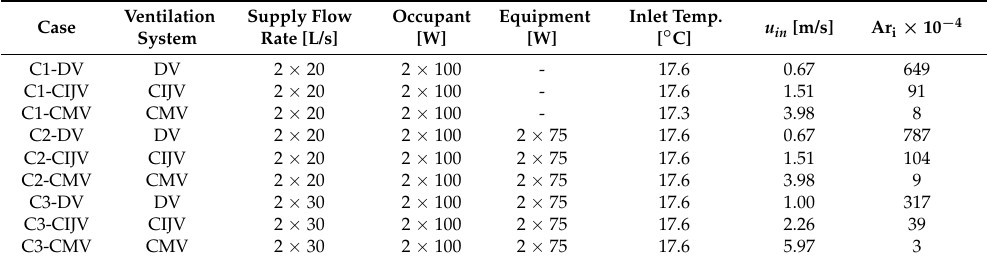
Table 2. Case conditions for different ventilation systems.